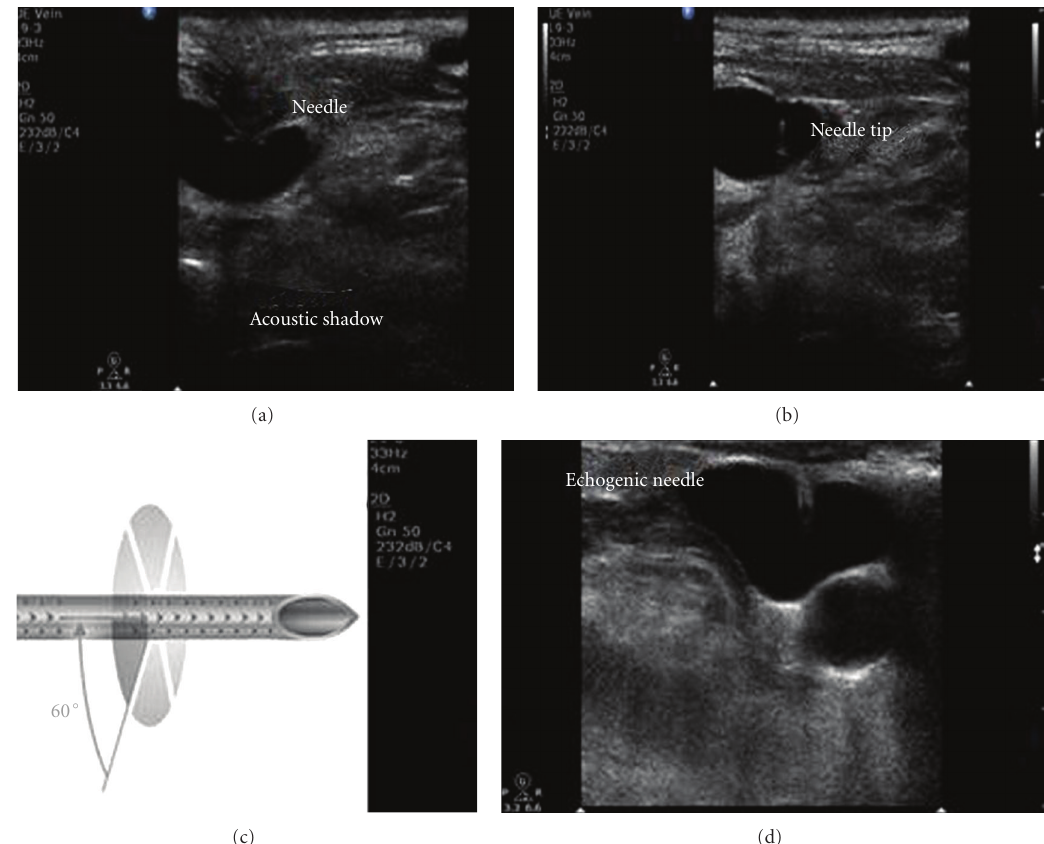
Figure 2: Nonechogenic cannula entering the anterior wall (a) and depicted within the lumen of the internal jugular vein, on the transverse axis (b); please observe that the echogenic cannula incorporates “cornerstone” reflectors arranged at its distal 2cm (c), which increases dramatically its visibility